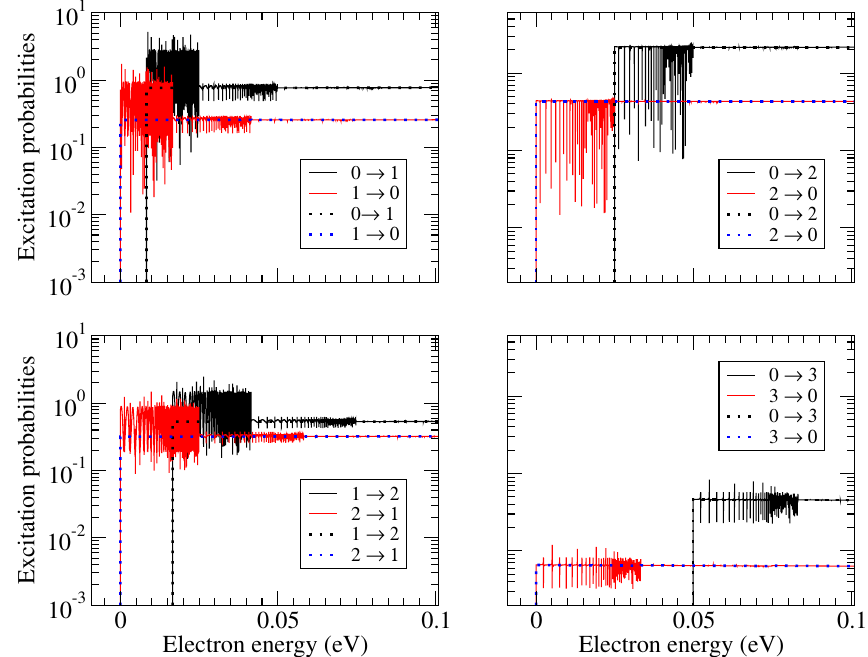
Figure 2. Rotational (de-)excitation probabilities for transitions between the four lowest rotational states of HeH + . Solid lines represent the results obtained with the applied closed-channel elimination procedure, while the dotted lines show the results for which the procedure was not